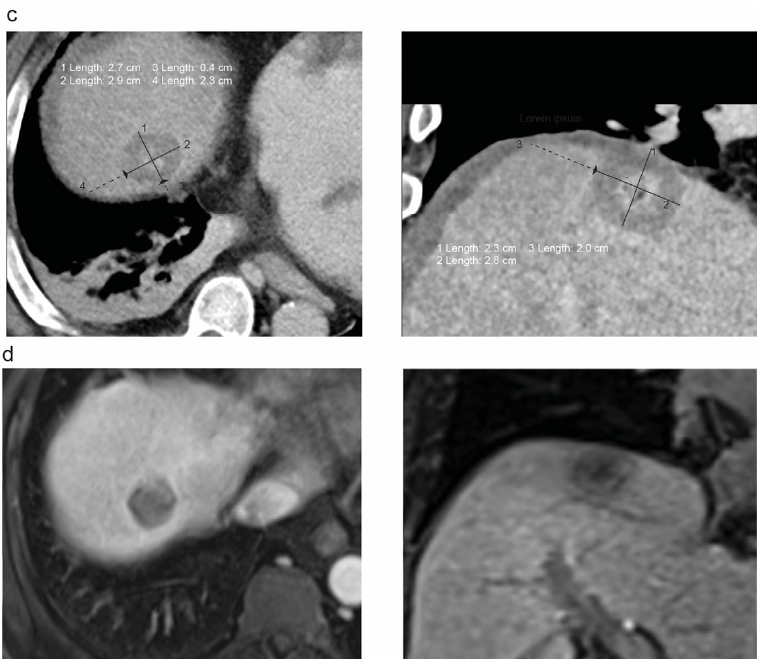
Figure 2. Example of minimal ablative margin assessment in MRI/CT scans of a 67-year-old man with HCC: ( a ) hepatic contrast-enhanced MRI (left: arterial phase, right: hepatobiliary phase) before MWA treatment; ( b ) contrast-enhanced planning CT scan (arterial phase) with pre-interventional measurements as performed in our study; ( c ) contrast-enhanced control CT scan (portal venous phase) after complete tumor ablation with postinterventional measurements; ( d ) contrast-enhanced follow-up MRI (left: arterial phase; right: hepatobiliary phase) 6 months after MWA with no evidence for local tumor progression.